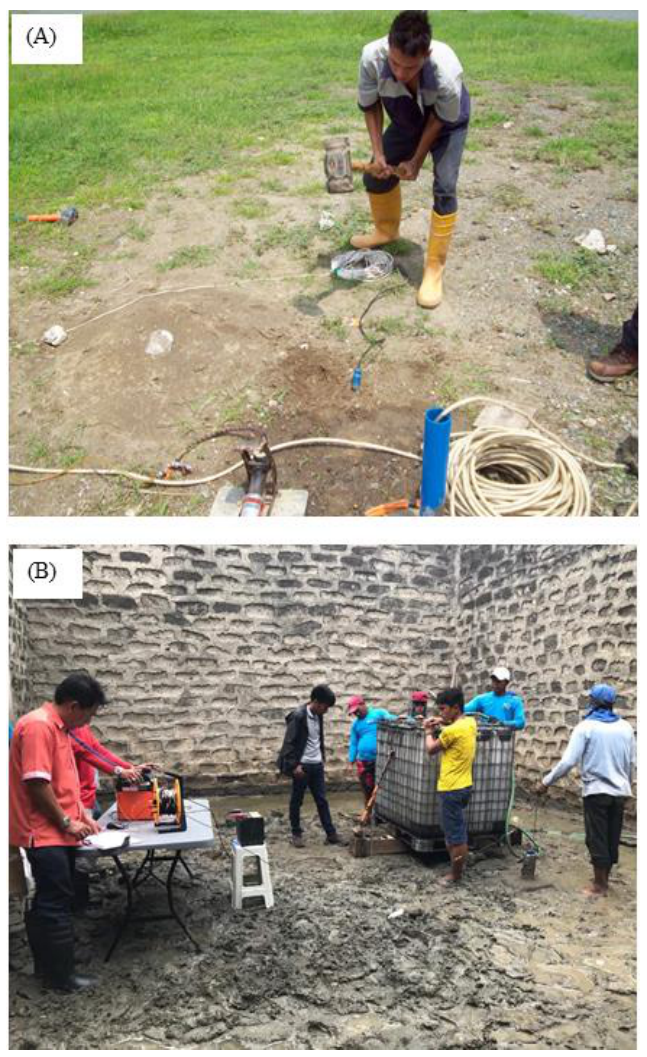
Figure 10. On-site seismic down-hole data acquisition; ( A ) P-wave and ( B ) S-waves.